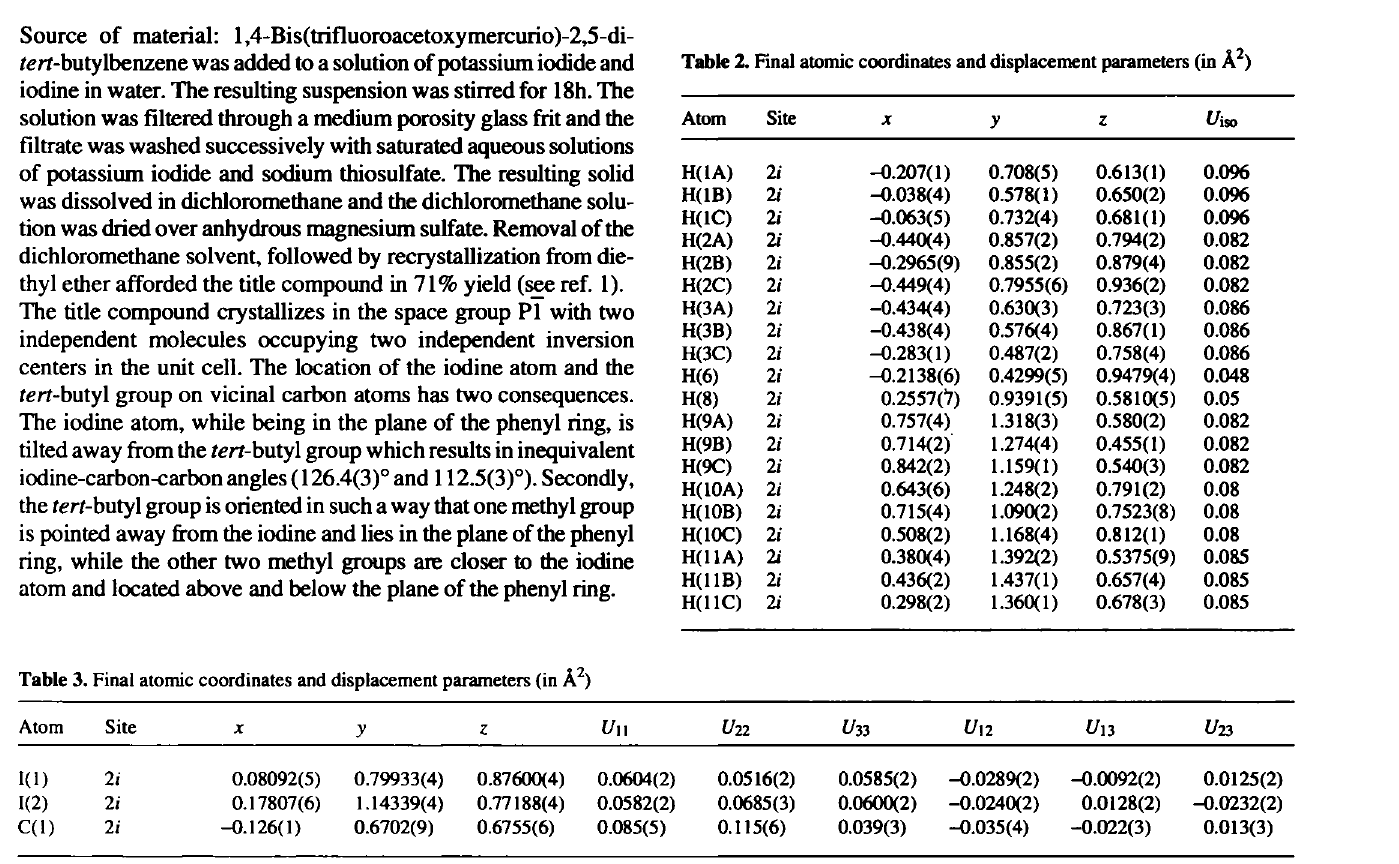
Table 3. Final atomic coordinates and displacement parameters (in A^)